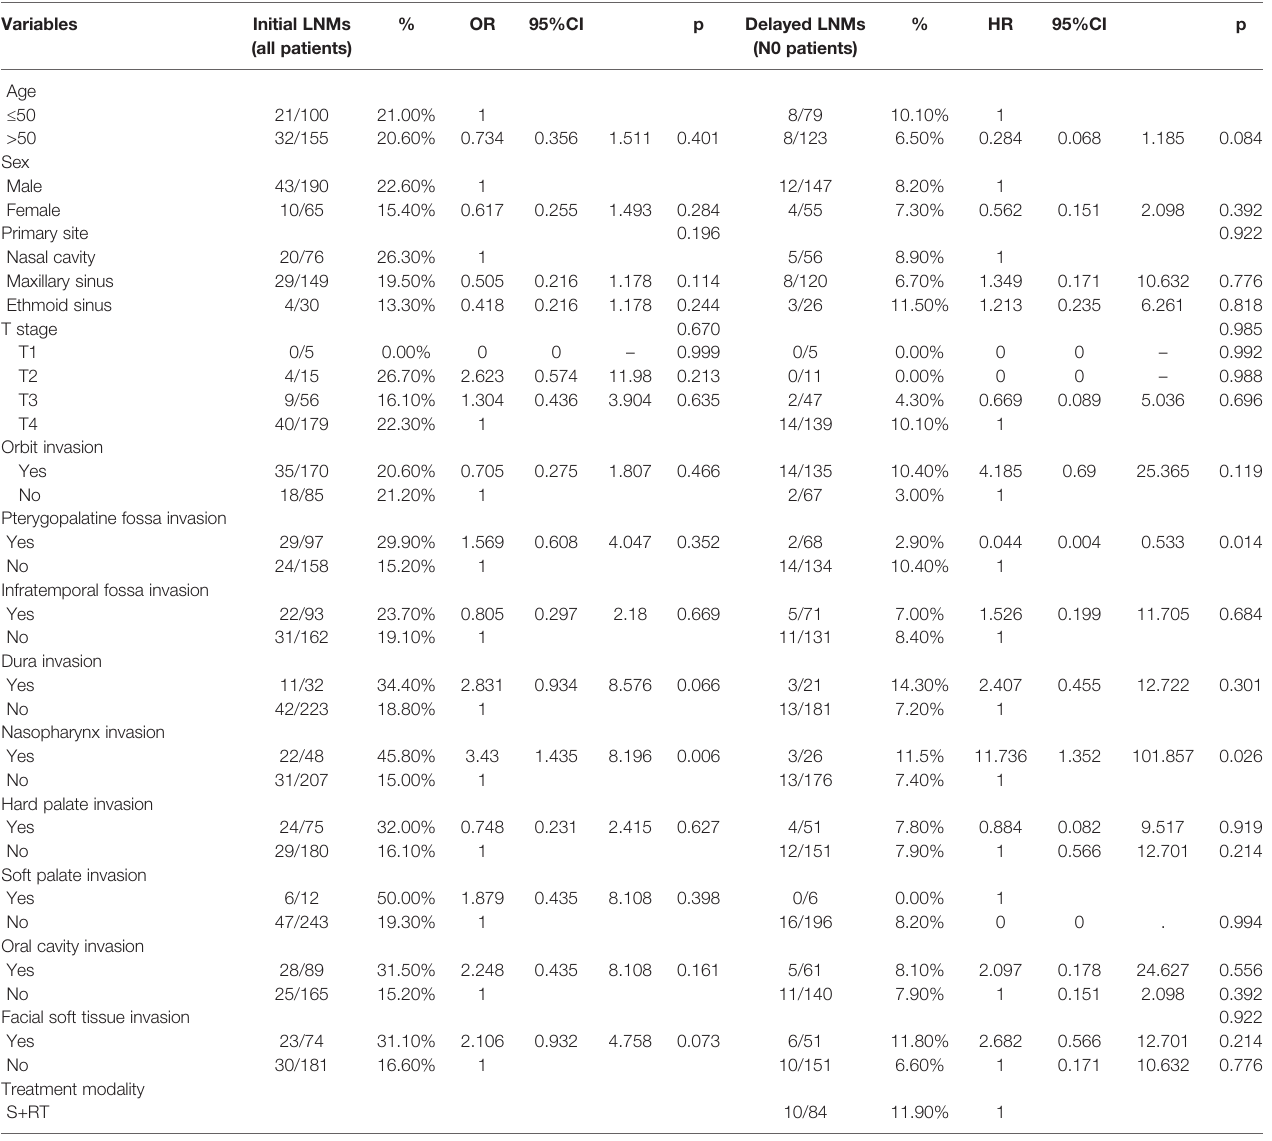
TABLE 5 | Multivariate logistic analysis of risk factors for initial lymph node metastasis.